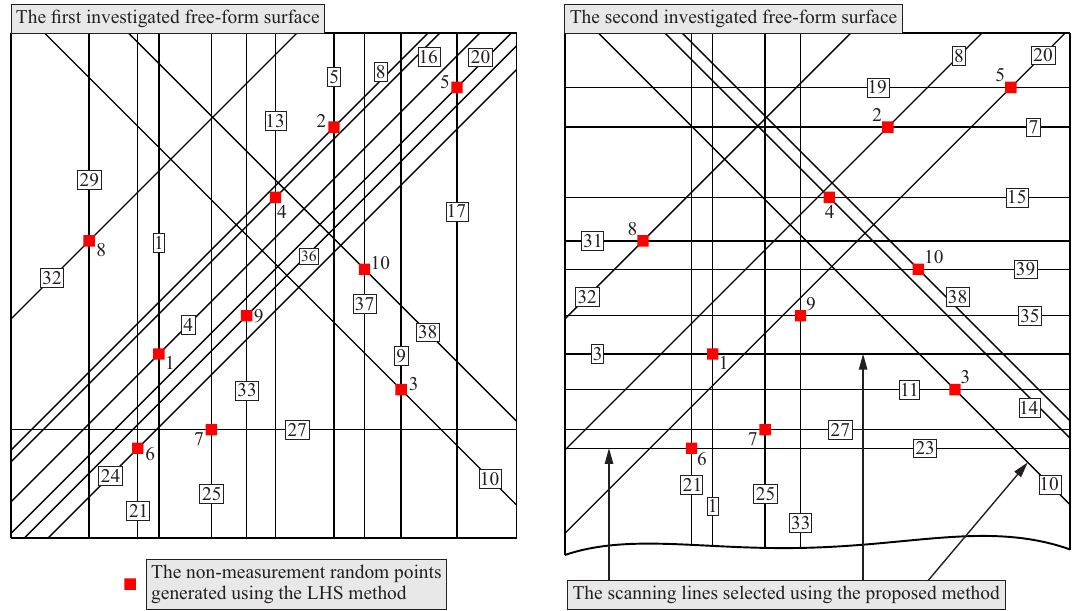
Figure 13. The selected scanning lines for two investigated free-form